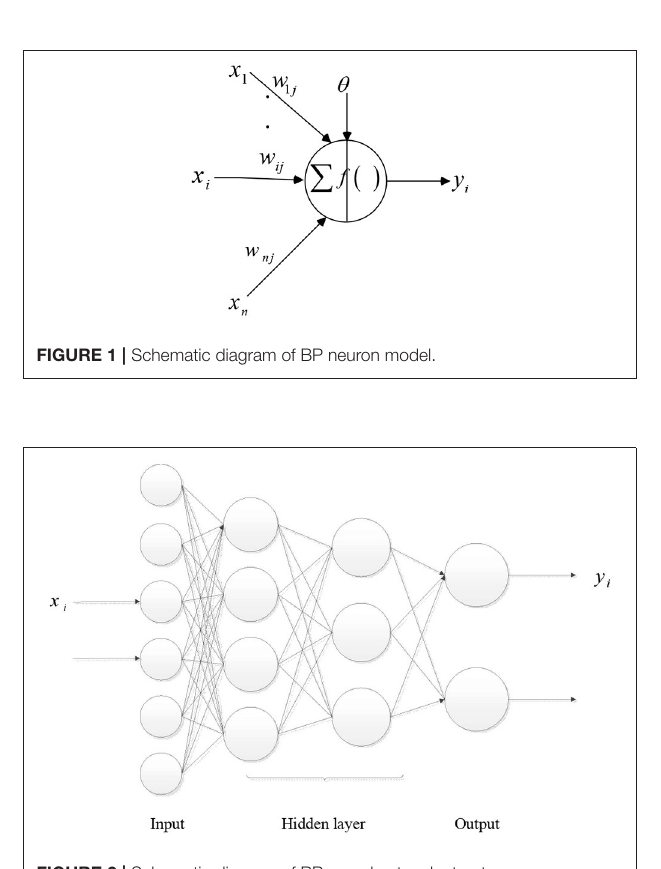
FIGURE 2 | Schematic diagram of BP neural network structure.